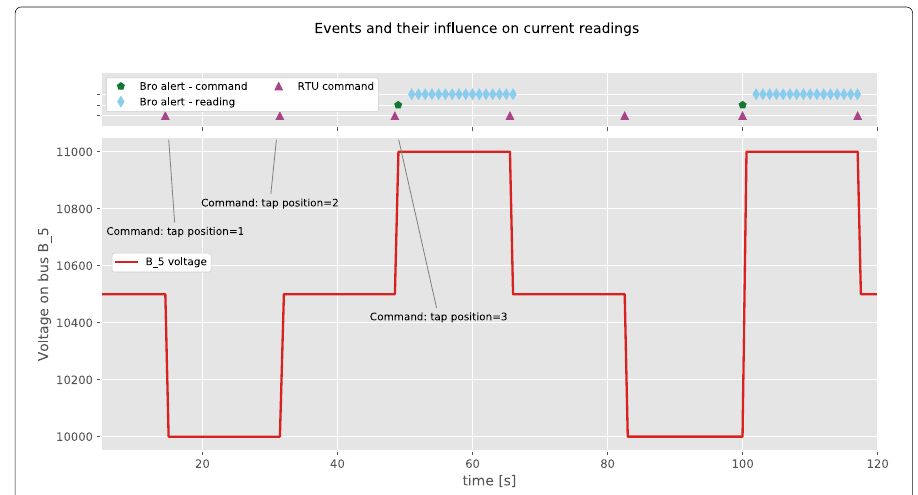
Fig. 7 Illustration of the effects of an attack scenario on RTU 1 with local monitoring. Figure 7 illustrates the effects of an attack on a transformer controlled by RTU 1 . Here, the traffic monitoring is enabled, however the commands are not discarded in order to present the outcome of those commands. The voltage on bus B_5 is shown in red on the y-axis for different simulation times (in seconds). It can be seen that Bro issues alerts (marked in green) when receiving commands to change the tap switch position, such that the secondary voltage would become to high. Once the command has been executed, a Bro warning is issued upon every sensor reading (marked with the blue